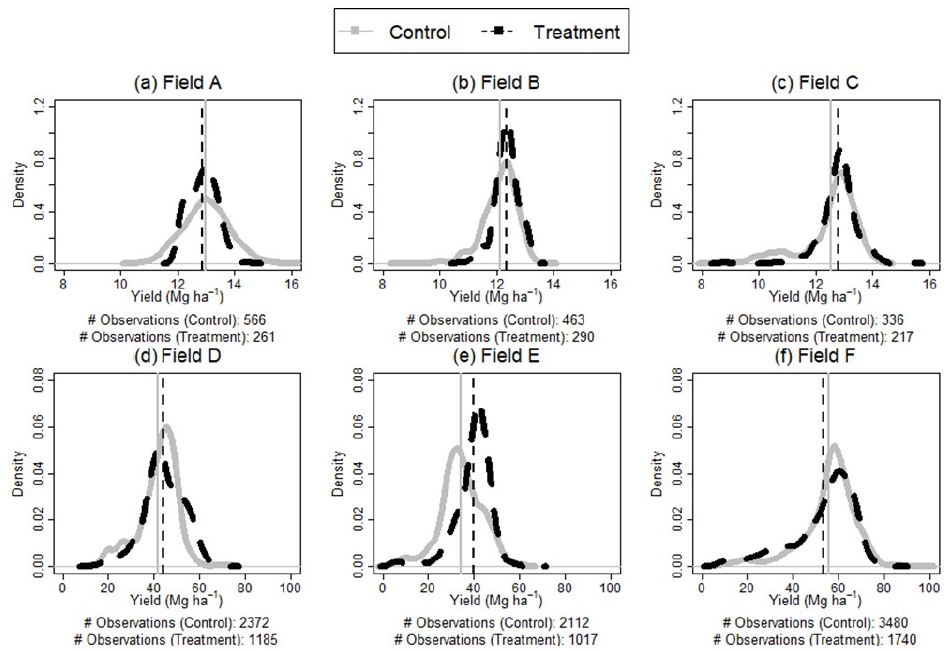
Figure 3. Density plot representing corn yield distributions of a N treatment strip (higher N) and the neighboring control strips. The dotted black and the solid grey vertical lines represent the average yield for the N treatment strip and the control strips, respectively. Fields A, B, C ( a – c ) were harvested for grain. Fields D, E, F ( d – f ) were harvested for silage.